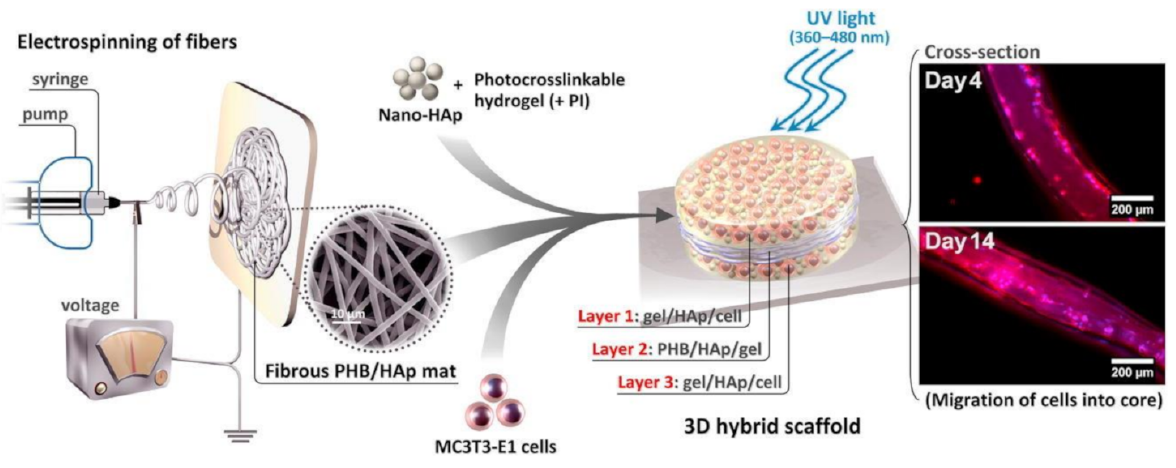
Figure 3. Scheme of tri-layered PHB/nHA scaffold fabrication and in vitro test visualization. Reprinted from [85] with permission from